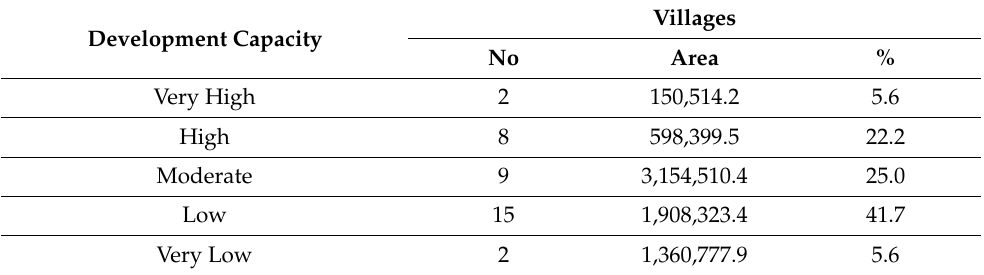
Table 12. Development capacity for each village